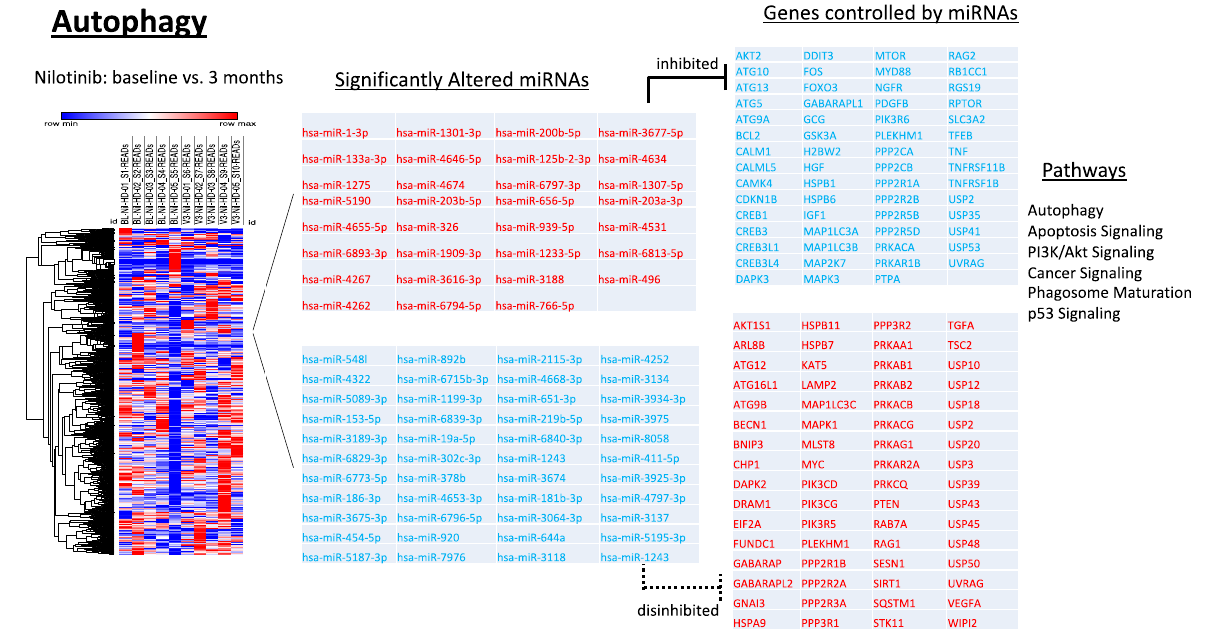
Figure 4. miRNAs target genes associated with autophagy. Gene ontology analysis revealed 31 upregulated and 44 downregulated miRNAs that target 122 genes experimentally observed to be associated with autophagic processing.